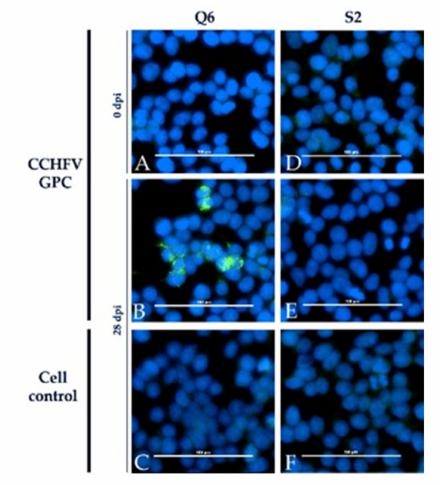
Figure 7. Euroimmun iIFA with cattle NSDV antisera: Results for one infected calf (Q6) are ex- emplarily presented together with the results for the mock control calf (S2). A specific staining is demonstrated for cells expressing CCHFV GPC ( B ). All controls (cell control: ( C ); serum prior infection: ( A ) did not lead to a positive signal. The control calf S2 did not test positive under any circumstances ( D – F